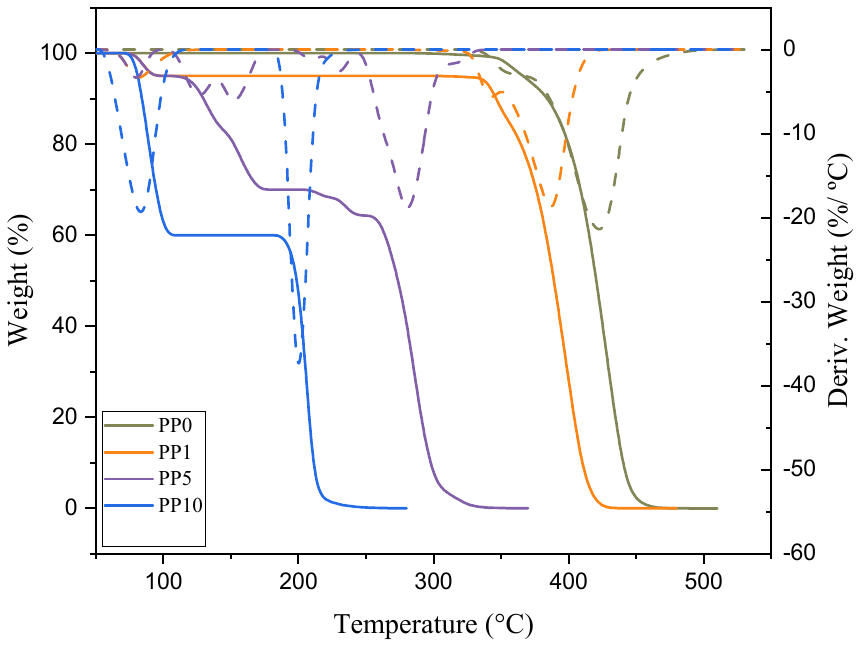
Figure 6. TGA and DTG of PP samples.